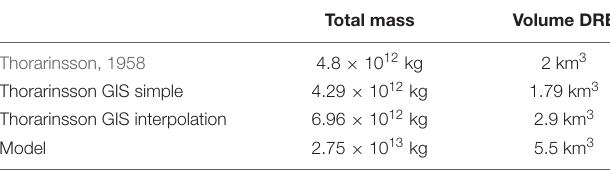
TABLE 2 | Estimation of total mass emitted during the 1362 eruption by using different ways to interpolate the isopachs drawn by Thorarinsson